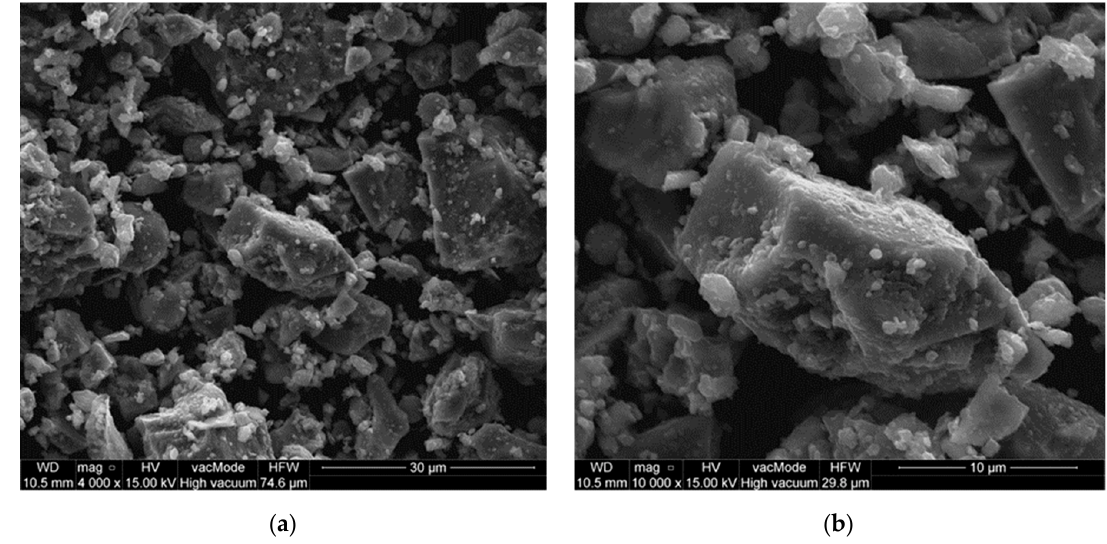
Figure 4. Scanning electron microscope image of basalt powder: ( a ) mag. ×4000; ( b ) mag. ×10000.